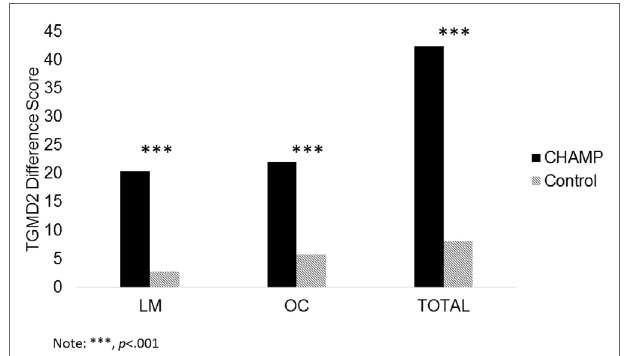
FigUre 2 | Differences between groups in motor skills change scores .